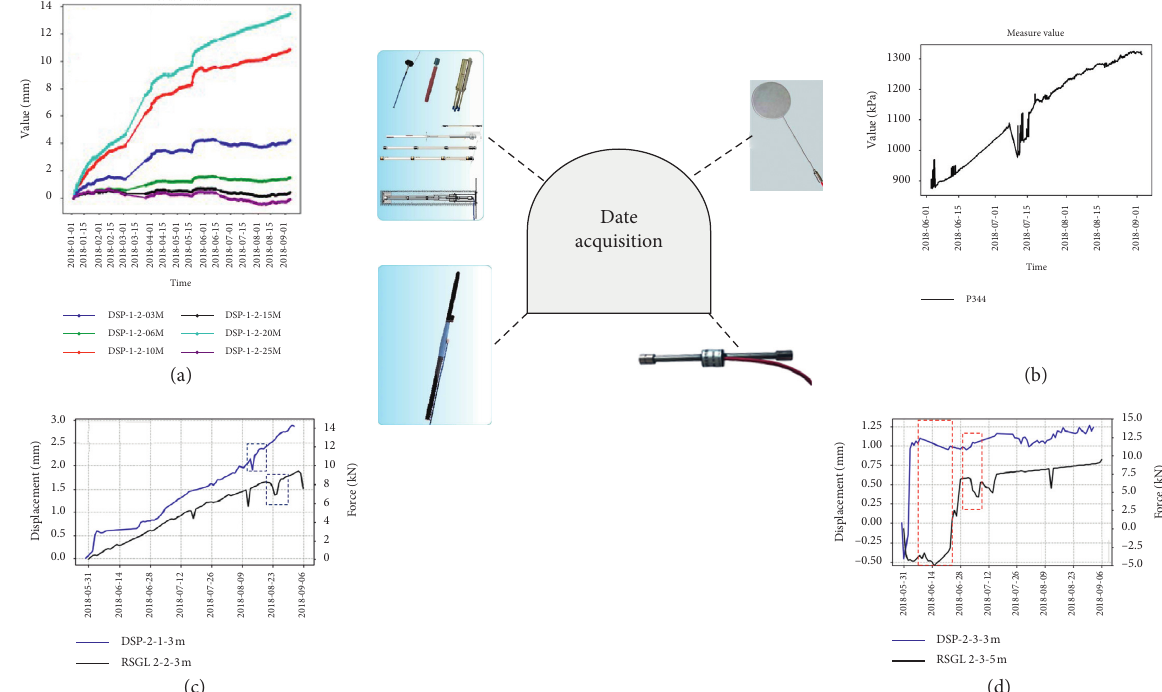
Figure 15: Multivariate data collection [10]. (a) Multipoint displacement gauge. (b) Pressure cell. (c) Bolt stress gauge. (d) Reinforcement stress gauge.